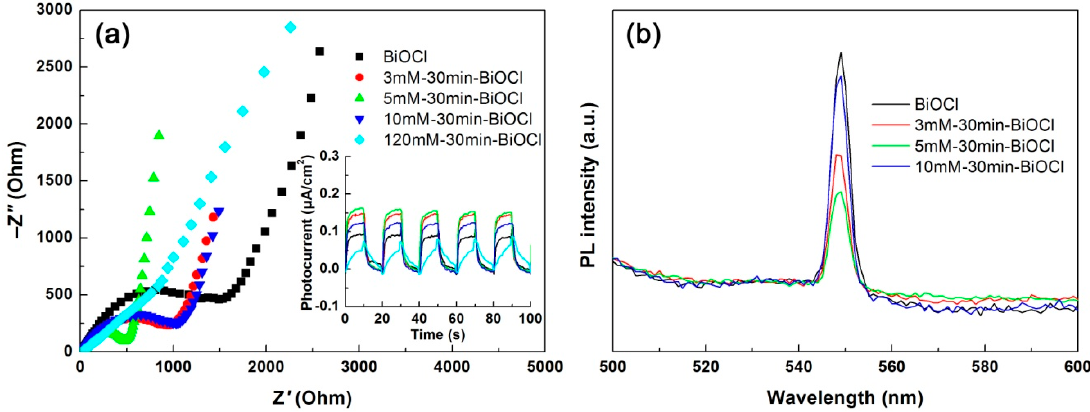
Figure 7. Nyquist plots of the electrochemical impedance spectroscopy (EIS) spectra ( a ), transient photocurrent response curves (inset in a), and PL spectra ( b ) of the NaBH 4 -treated BiOCl samples with different concentrations.